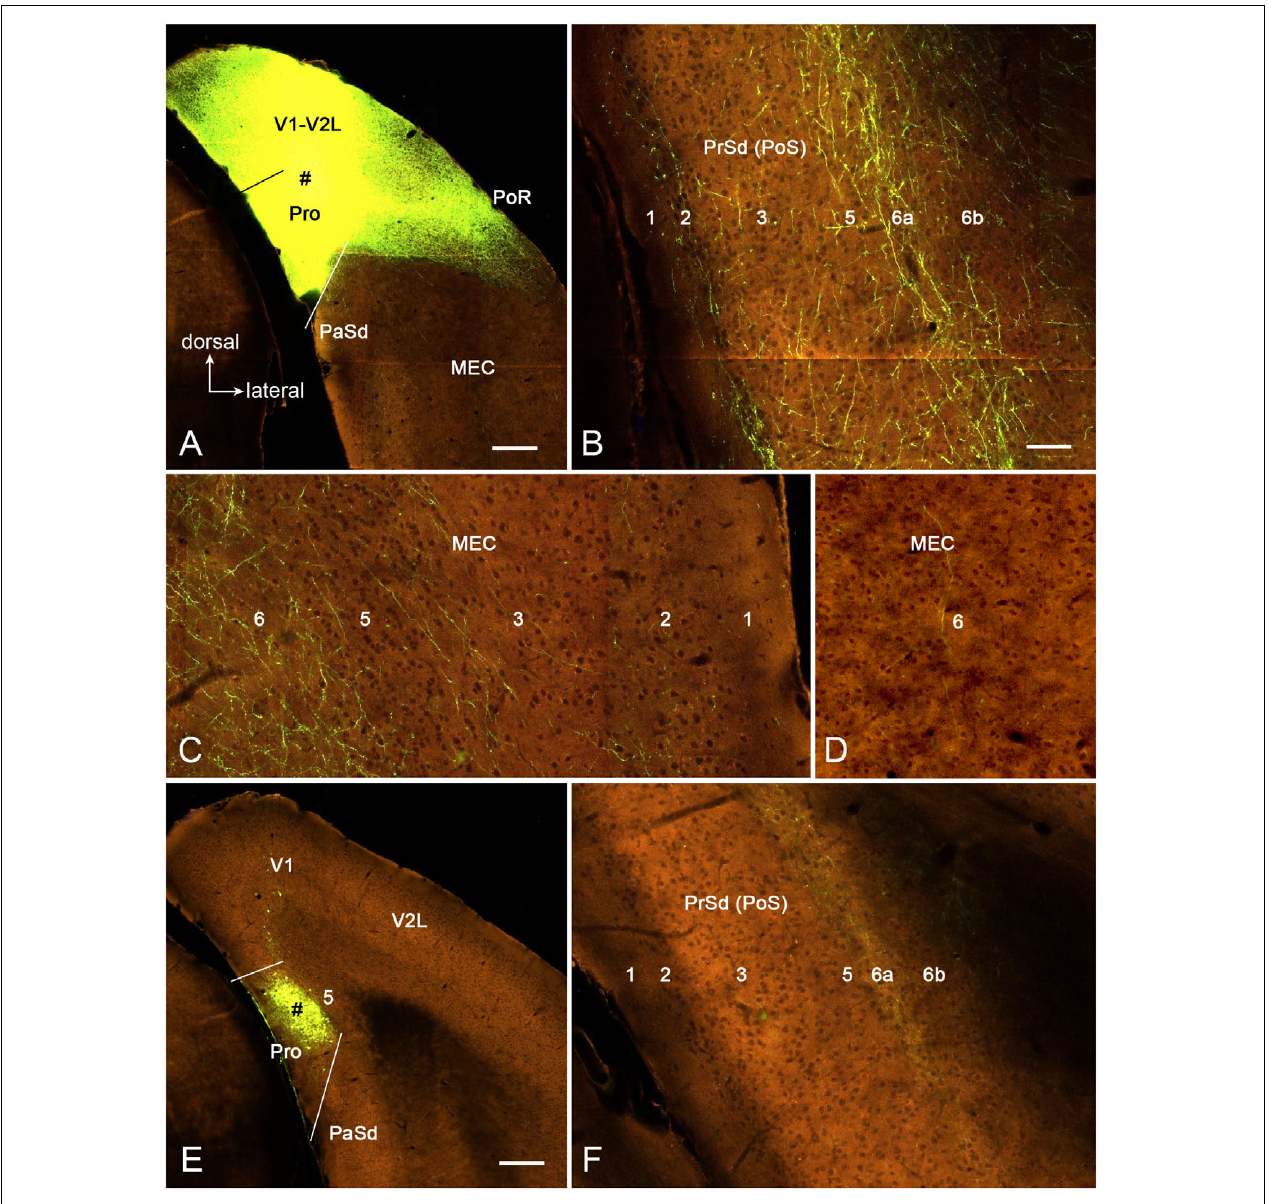
FIGURE 8 | Axon terminal labeling following anterograde viral tracer injections in the prostriata of two wild-type mice. All panels are from coronal sections. (A–C) One large injection (# in A ) involved in all layers of both prostriata and overlying visual cortex results in labeled axon terminals in PrSd ( B , mainly in layers 2, 5, and 6a) and medial entorhinal cortex (MEC) ( C , mainly in layer 6), respectively. (D–F) Another small injection (# in E ) restricted in layers 2–3 of the prostriata results in labeled axon terminals in PrSd ( F , mainly in layer 6a) with much less labeling in MEC ( D , layer 6). Bars: 280 µ m (A) for (A,E) ; 70 µ m (B) for (B–D,F)